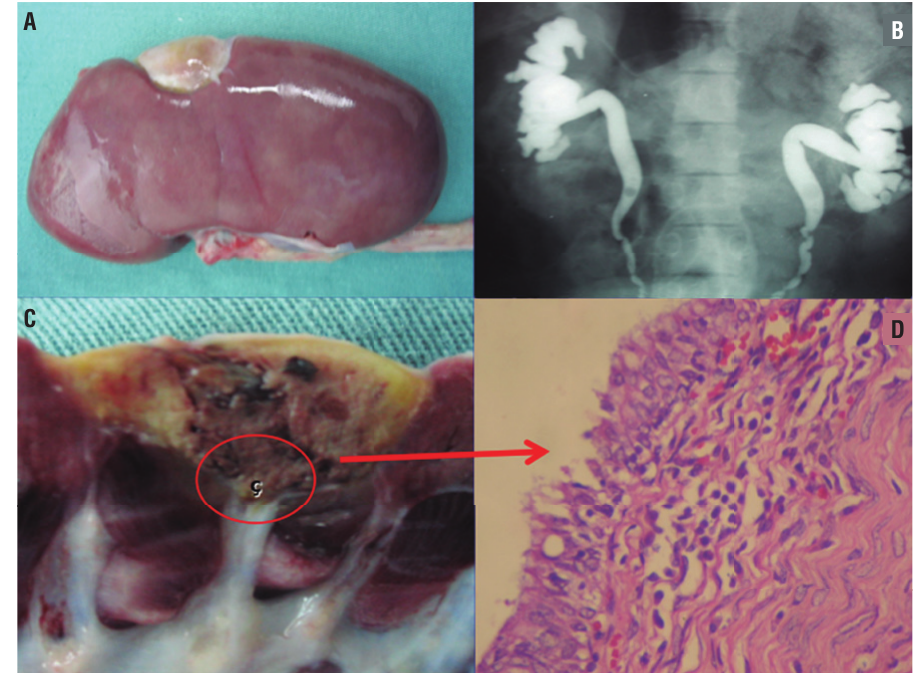
Figure 1: A) external aspect of the lesion; B) Ascending pyelogram without alterations; C) macroscopic aspect of the excretory system; D) Microscopy, 40X,